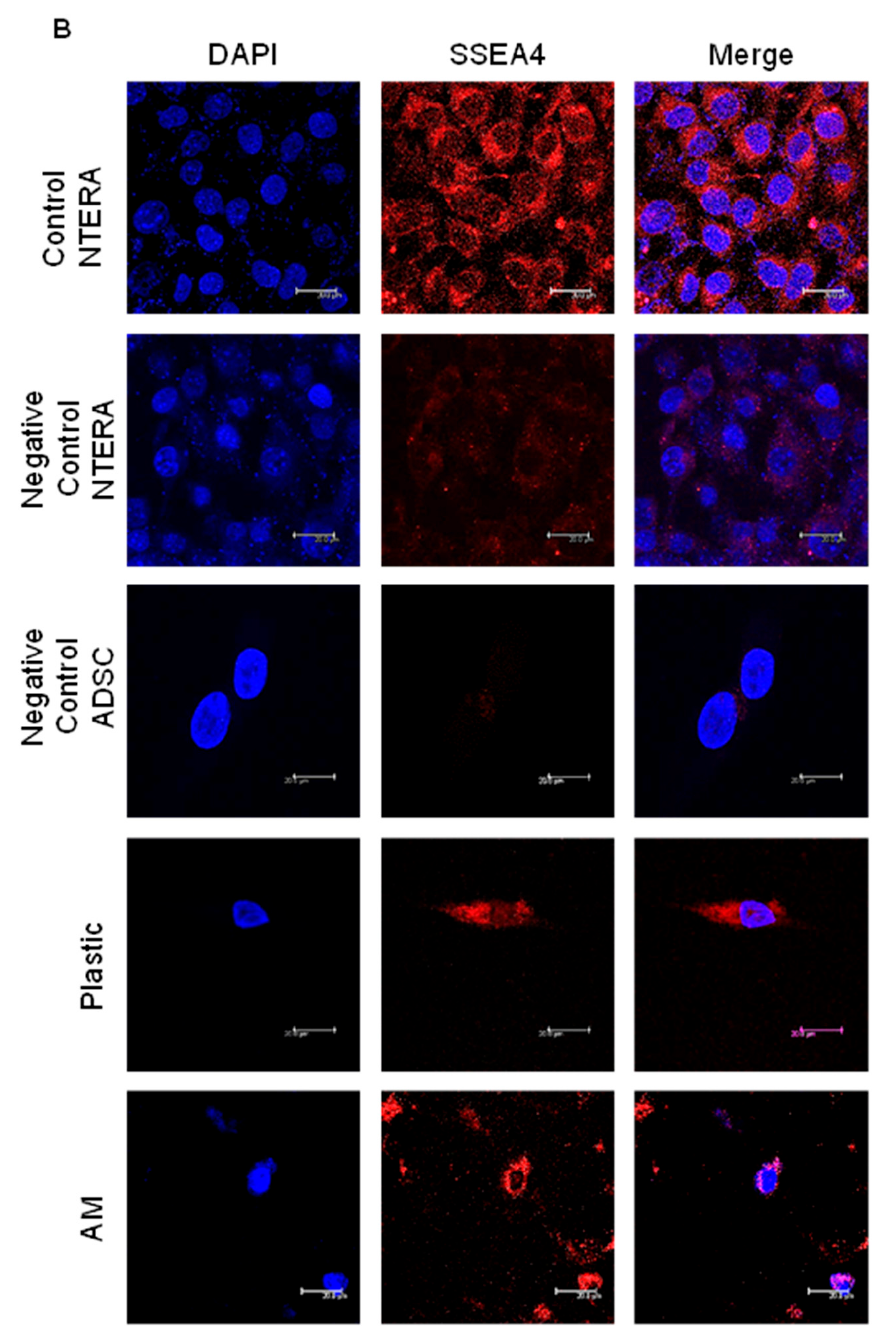
Figure 5. ( A ): p63 α /BMI immunofluorescence during LSC differentiation. Confocal microscopy images showing double p63 α /BMI immunofluorescence and DAPI staining. HaCat cells as positive control; LSCs from donor 2 on plastic coverslips or amniotic membrane carriers after 13 days at the second differentiation step. ( B ): SSEA4 immunofluorescence during LSC differentiation. Confocal microscopy images showing SSEA4 immunofluorescence and DAPI labeling. NTERA cells as positive control showing scattered cytoplasmic labeling; NTERA cells and native ADSCs as negative controls incubated with secondary antibody only showing no labeling. LSCs from donor 2 on plastic or on amniotic membrane carriers after 11 or 10 days at the second differentiation step, respectively. All images feature a scale bar of 20 µ